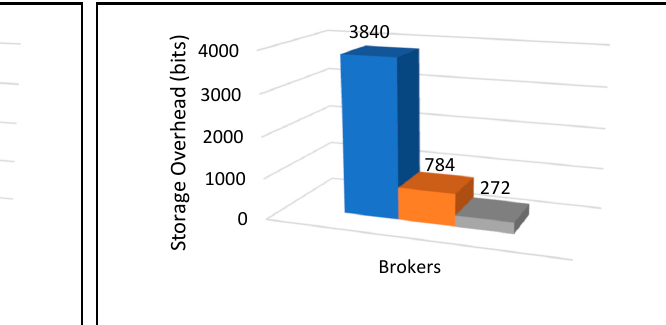
Figure 13. Communication overhead for clients and brokers in Diro’s scheme, our scheme, and Amanlou’s scheme. The paper of Amanlou [23] proposed a lightweight and secure authentication scheme between brokers and IoT devices for a publish–subscribe protocol (MQTT) in a distributed fog computing architecture using the Elliptic Curve Diffie–Hellman Ephemeral (ECDHE) key exchange algorithm along with the pre-shared key (PSK). Based on the proposed